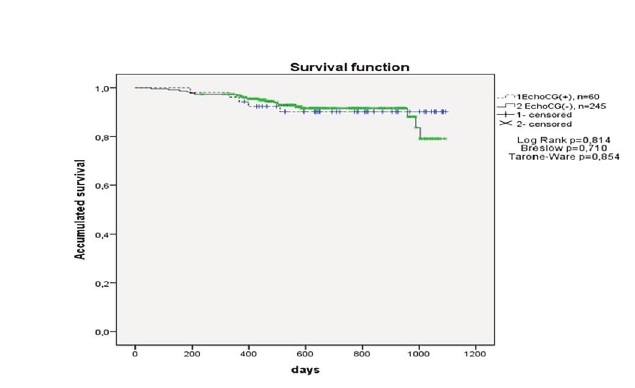
Figure 2 - Kaplan-Meier survival curves for the presence (absence) of EchoCG